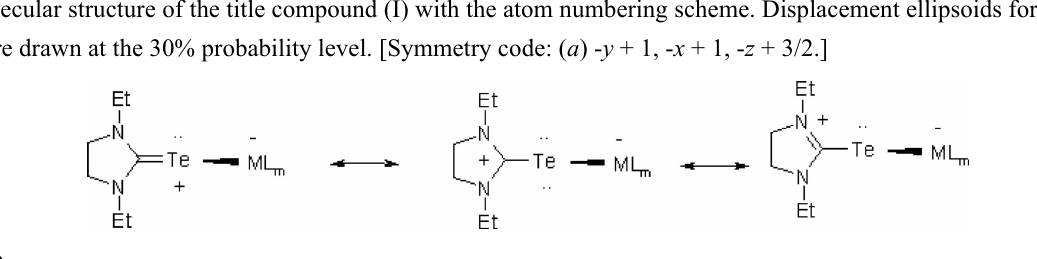
Figure 2 The resonance hybrids of tellurourea metal complexes (Lappert et al. ,